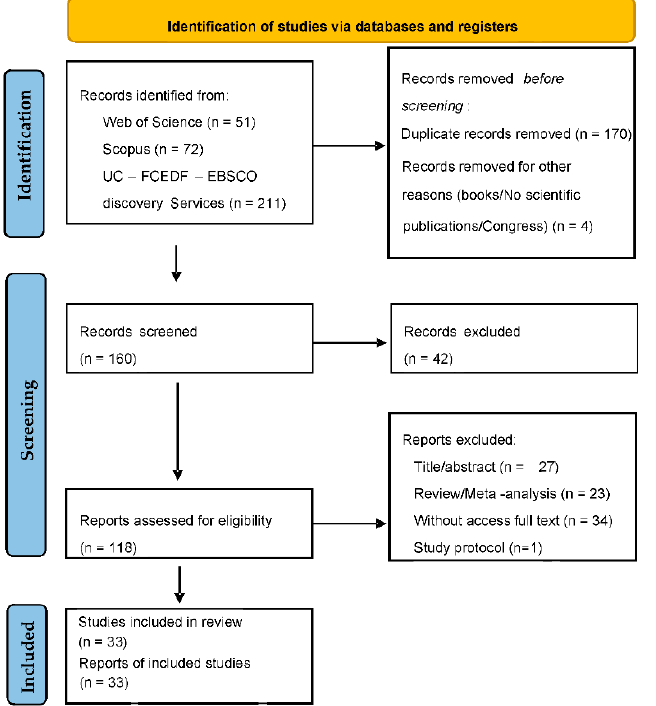
Figure 1. PRISMA 2020 flow diagram for new systematic reviews, which includes searches of databases and registers only (adapted from [14]).